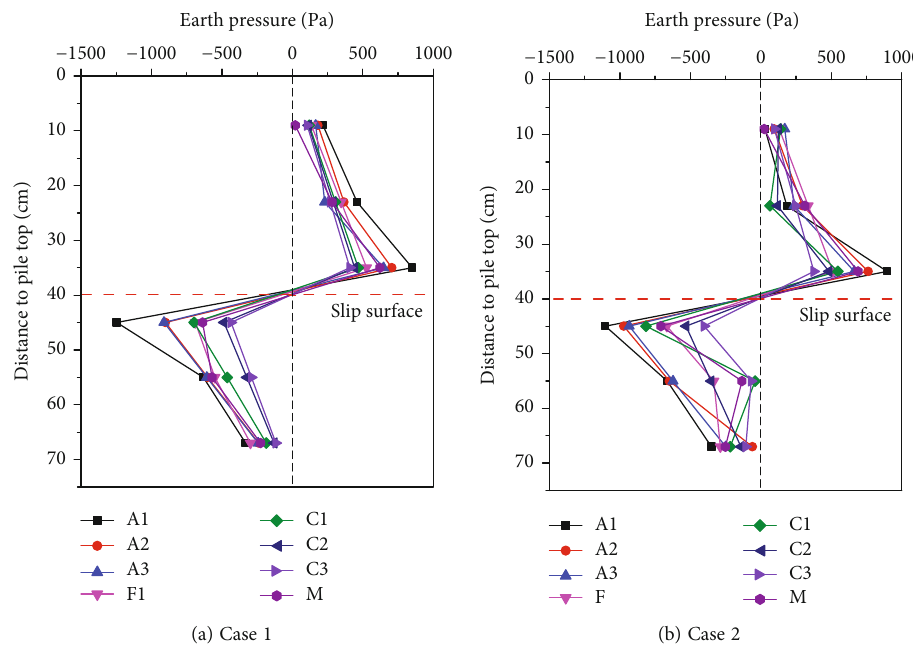
Figure 11: Earth pressure distribution of di ff erent cases ( p = 20 kPa Table 3: Comparison of extreme values of earth pressure on piles ( p = 20 kPa ).